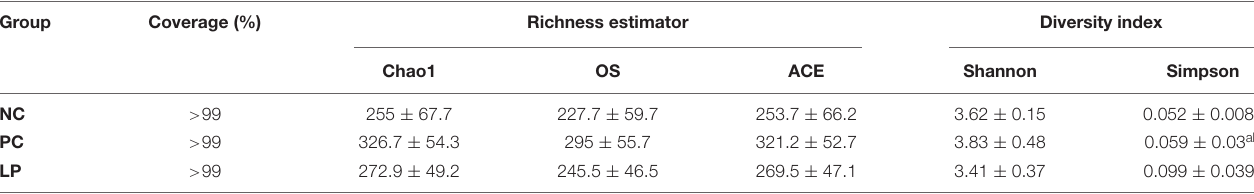
TABLE 3 | Alpha diversity indices of the colonic microbiota of weaning piglets.